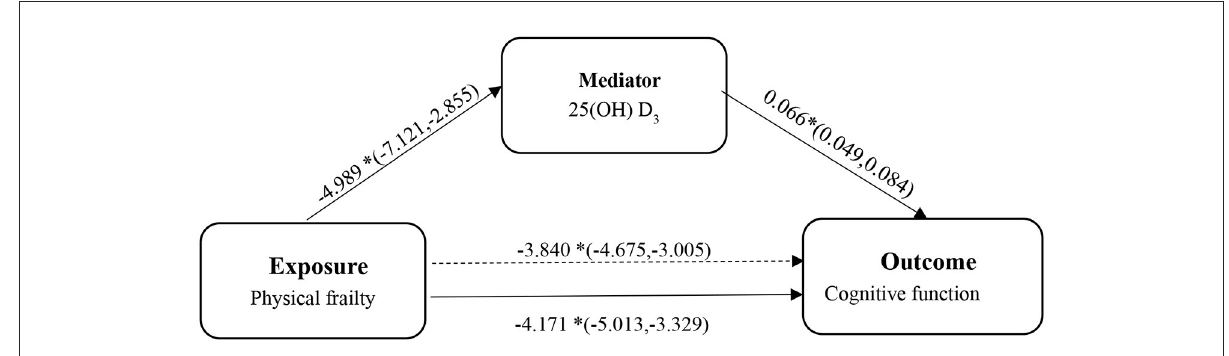
FIGURE1 The diagram of the mediation analysis of physical frailty on cognitive function. * p <